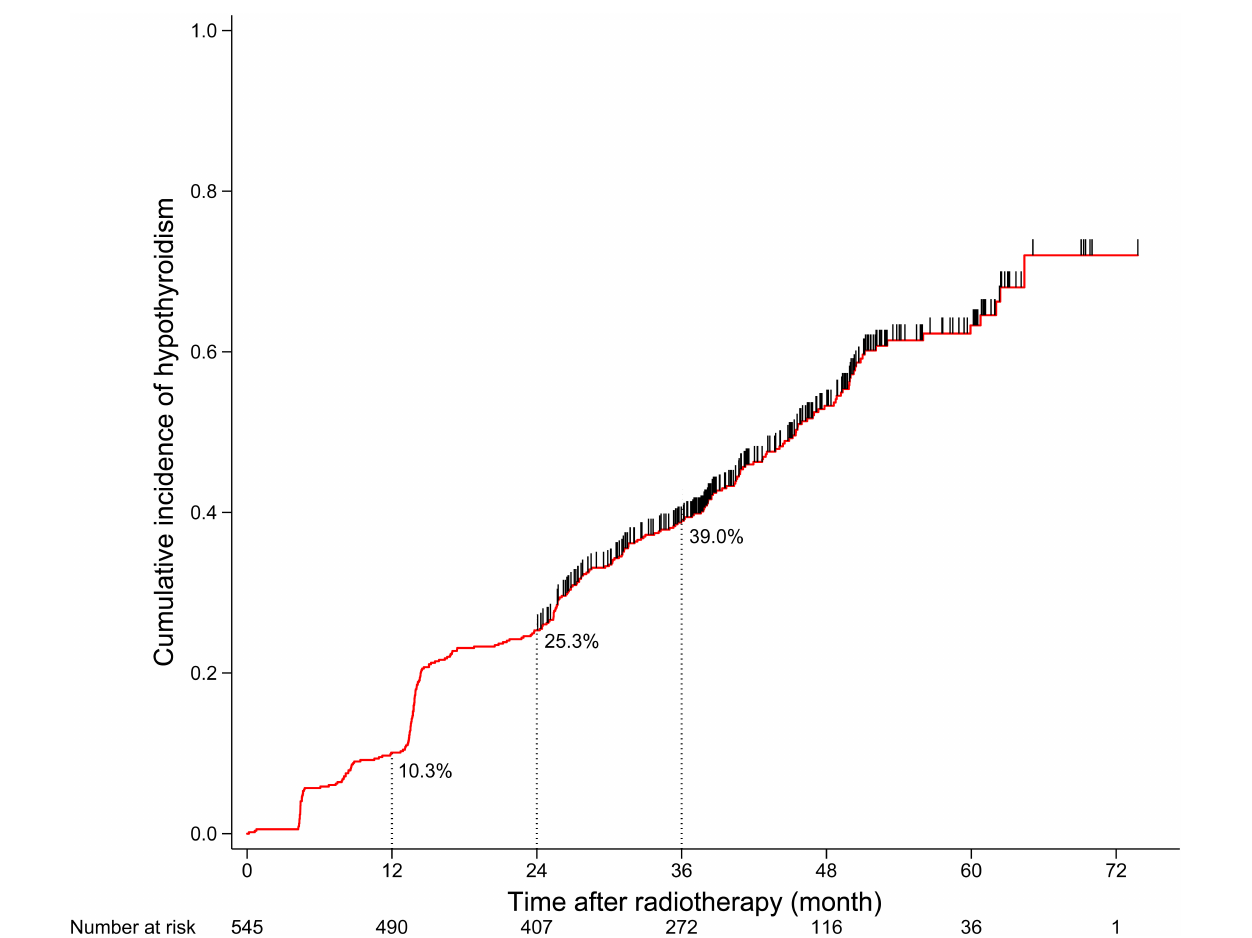
FIGURE 1 | Cumulative incidence curve of hypothyroidism for the whole cohort.